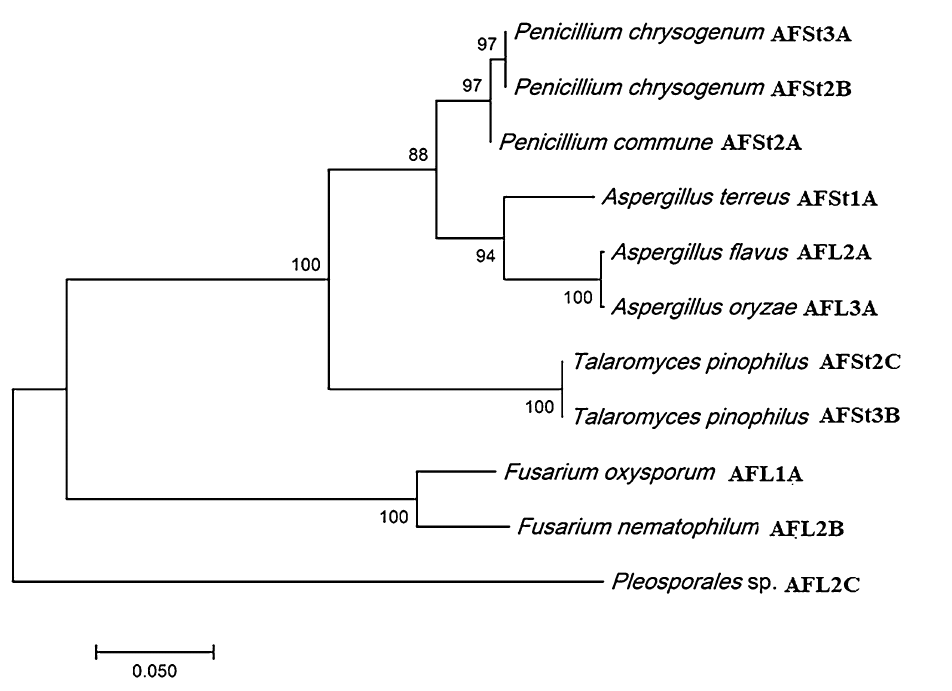
Figure 2. Neighbour ‐ joining phylogenetic tree based on ITS ‐ rDNA sequences of A. annua -derived fungal